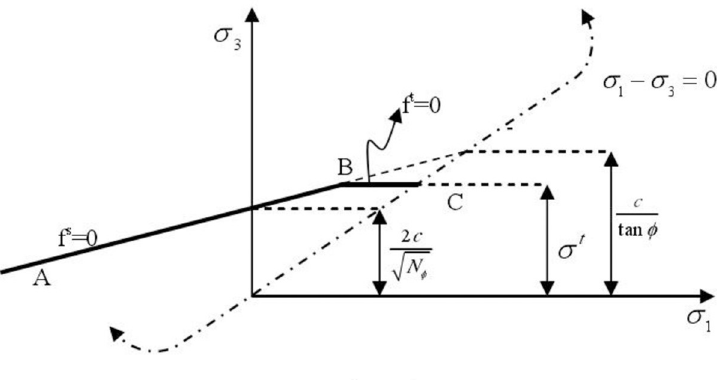
Fig 1. Mohr–Coulomb model failure criteria.